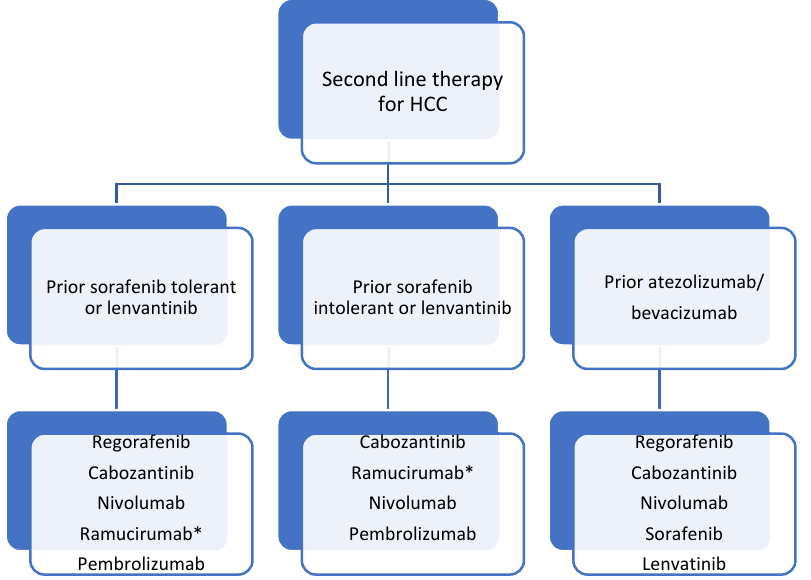
Figure 2. Second-line treatment options for advanced hepatocellular carcinoma. HCC—hepatocellular carcinoma. * Only in patients with AFP > 400 ng/mL.